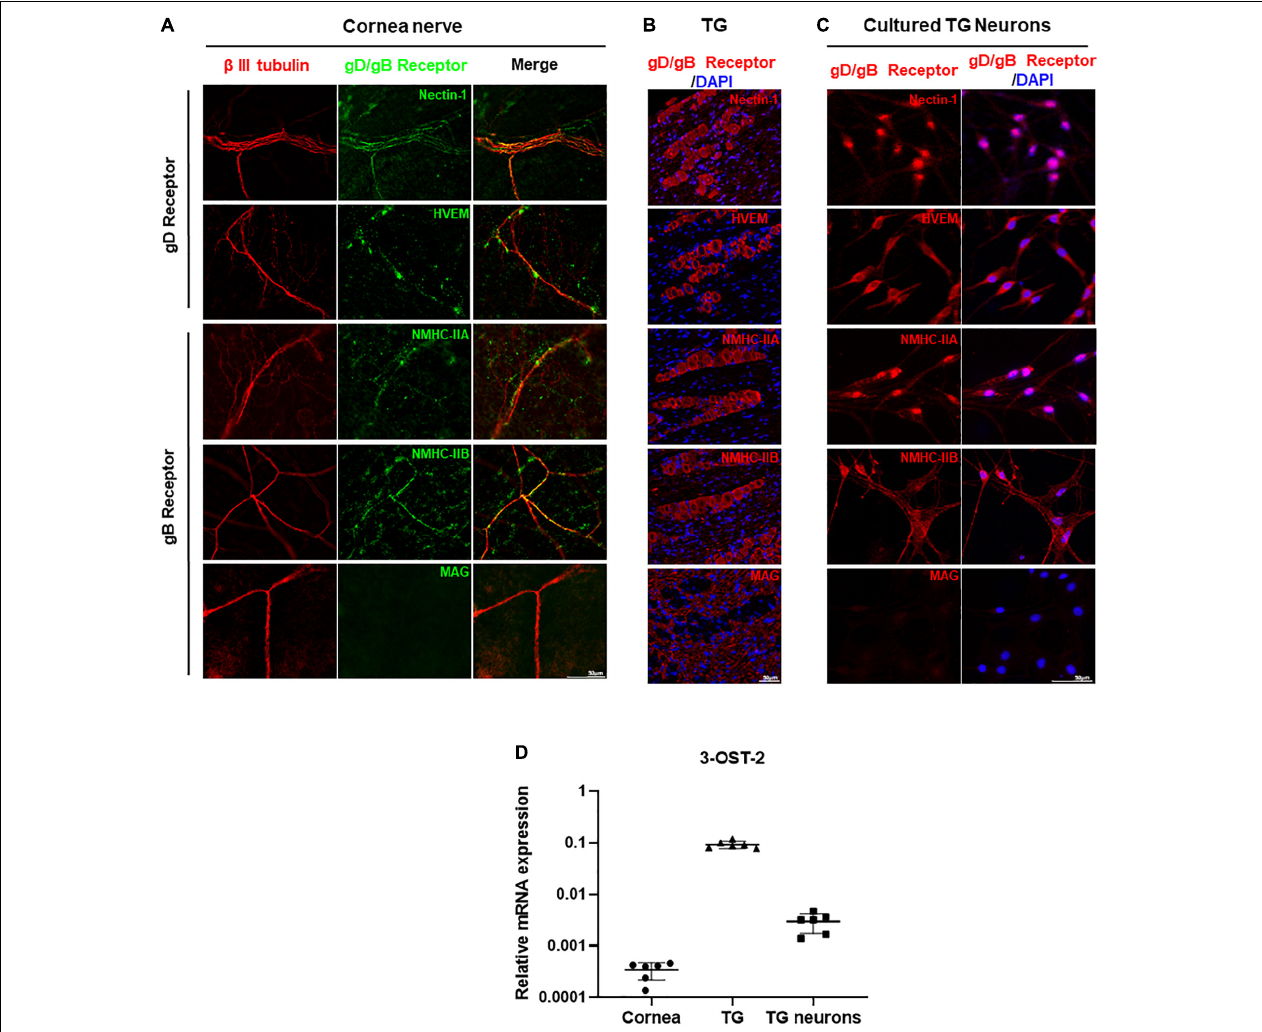
FIGURE 2 | HSV-1 gD/gB receptors were expressed in the corneal nerve of healthy mice. (A) Immunofluorescence analysis of gD/gB receptors shows that nectin-1, HVEM, NMHC-IIA, and NMHC-IIB were expressed in corneal nerves ( β III tubulin) of healthy mice, but not MAG. Shown is a single layer without z-axis stacking. (B) Immunofluorescence analysis of gD/gB receptors in the tissues of TGs shows that nectin-1, HVEM, NMHC-IIA, and NMHC-IIB were expressed, while MAG was only expressed in the myelin sheaths in TGs. (C) Immunofluorescence analysis of gD/gB receptors in the cultured TG neurons shows that nectin-1, HVEM, NMHC-IIA, and NMHC-IIB were expressed, but not MAG. (D) qPCR analysis of 3-OST-2 mRNA levels shows that 3-OST-2 was expressed in corneas, TGs, and cultured TG neurons from healthy mice ( n = 6). The 3-OST-2 mRNA expression of each sample relative to GAPDH was calculated using the metric 2 − (cid:49) CT .